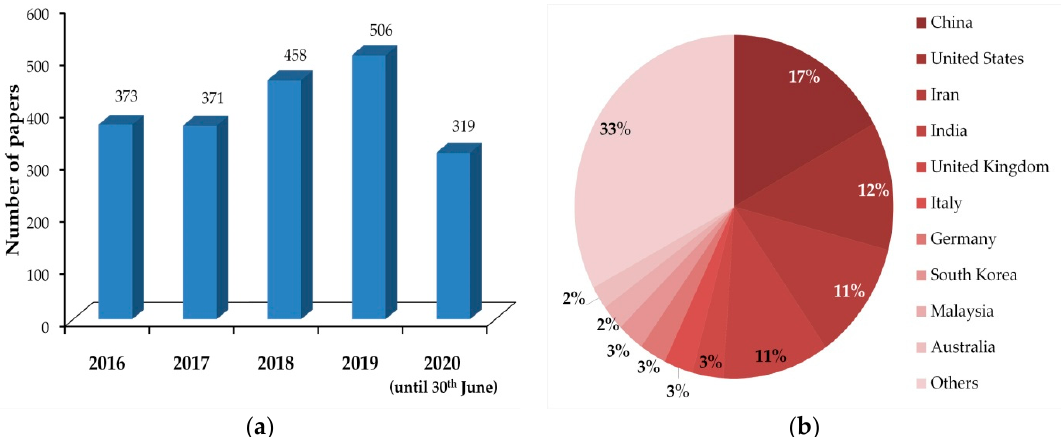
Figure 3. Papers dealing with epoxy nanocomposites, published between 2016 and 30 June 2020, found in the Scopus database: ( a ) papers per year; ( b ) authors’ affiliation per country.